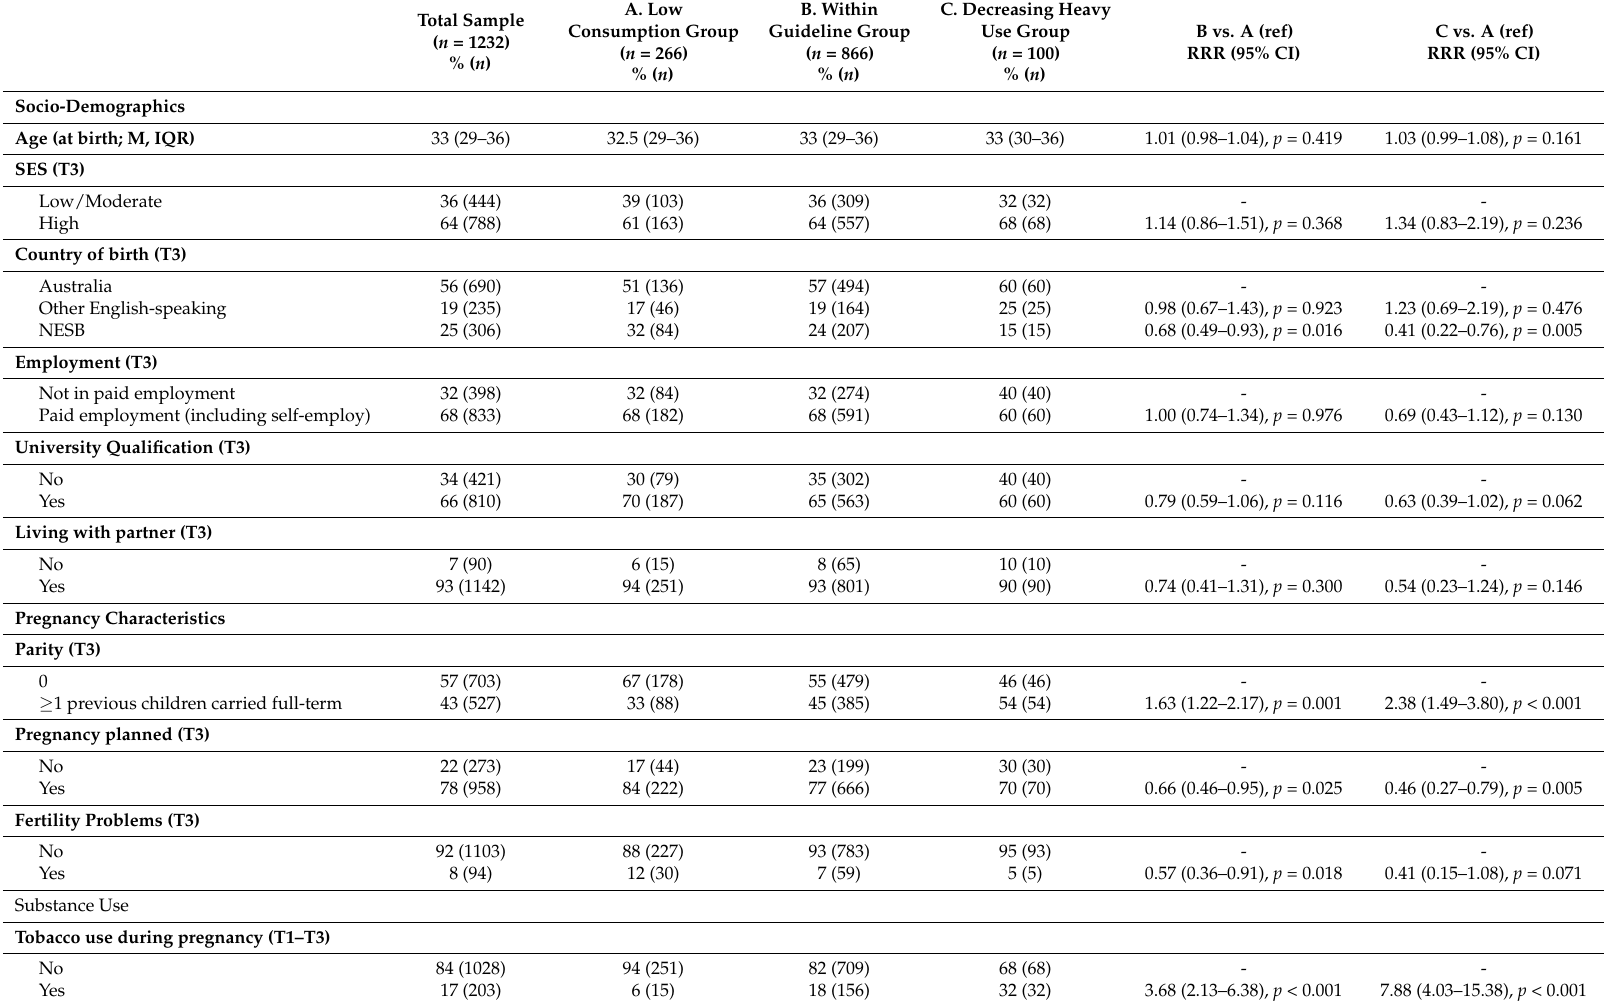
Table 3. Maternal predictors of guideline adherence trajectory group ( n =